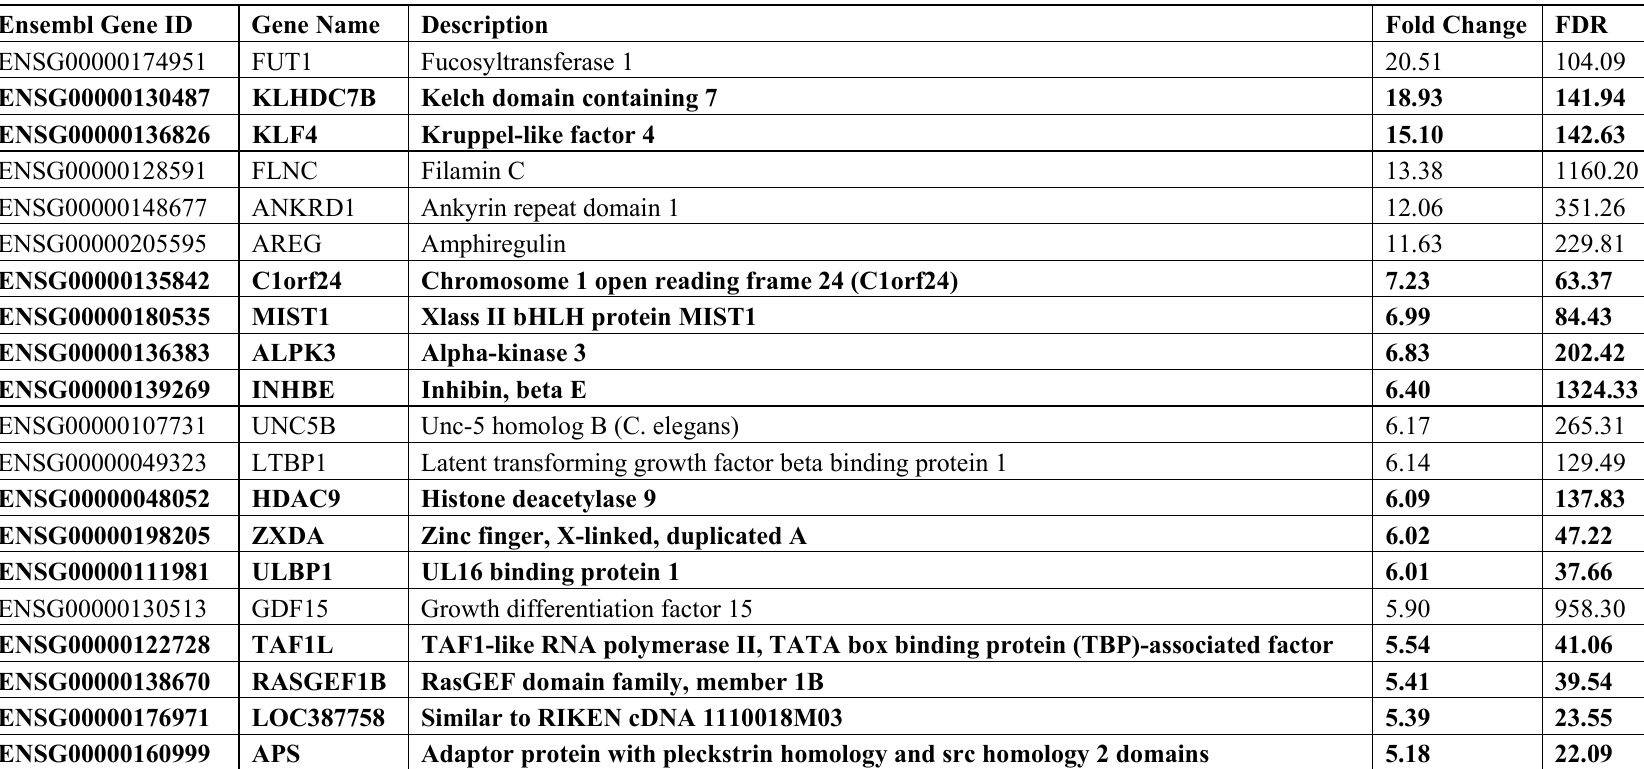
Table 1. The 50 most highly upregulated genes during acute HCV infection. The USeq DefinedRegionScanSeqs (DRSS) application was used to count the sequence reads for each annotated gene and score them for differential expression. The scores were controlled by multiple testing and ranked by transformed false discovery rate (FDR) and fold change (Experimental procedures). An FDR of 20 represents an untransformed FDR of 0.01 or 1 false positive per 100 observations and an FDR of 50 represents an untransformed FDR of 0.00001 or 1 false positive per 100,000 observations. Annotated genes that were significantly increased after acute HCV infection, relative to mock-infected cells, are presented in the order of their fold change. Newly identified differentially expressed genes are shown in bold. Genes marked with * had higher fold change at 48 h than at 72 h. A complete list of significantly upregulated genes is provided in Supplemental Table